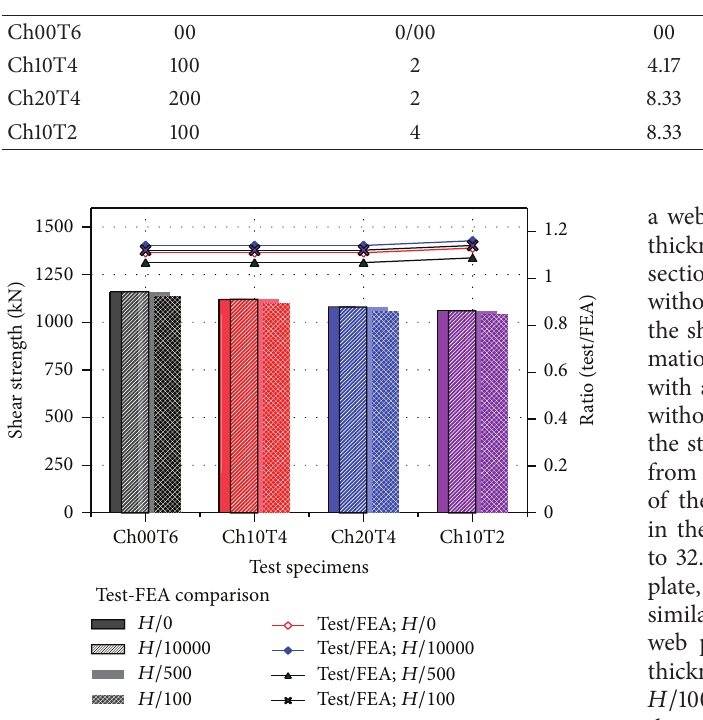
Figure 4: Comparison of test and FE analysis